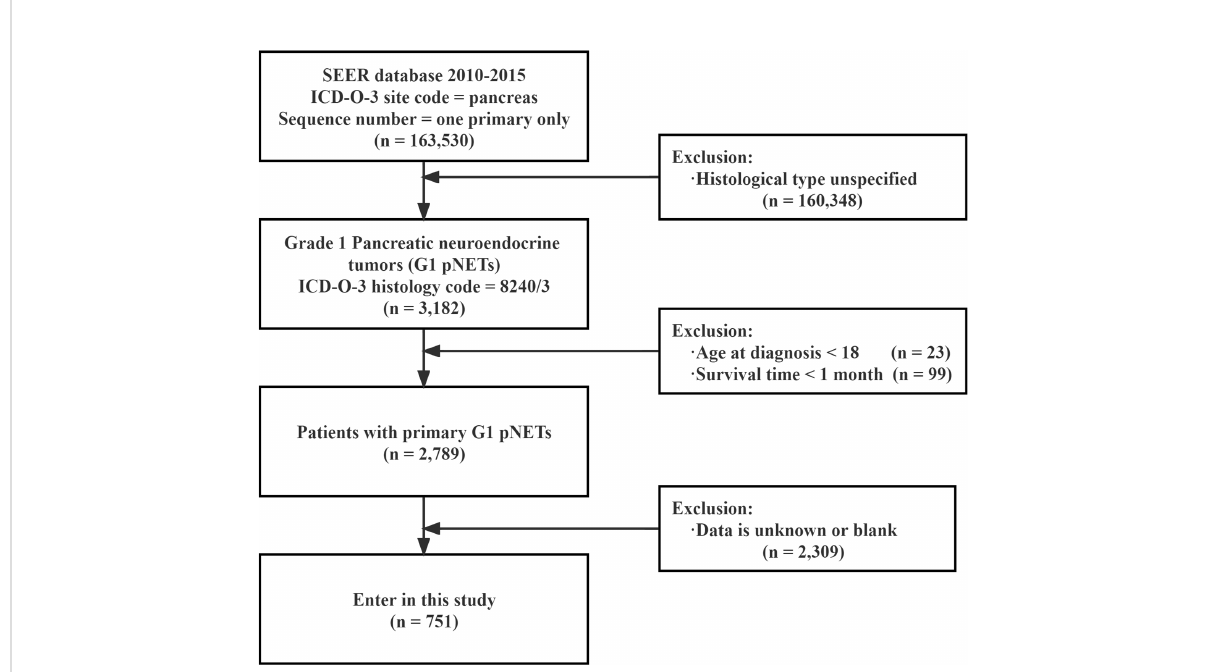
FIGURE 1 Flow chart showing the inclusion and exclusion process of patients in our study SEER : Surveillance, Epidemiology, End